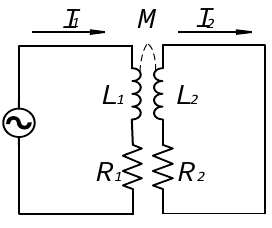
Figure 3. The equivalent circuit of the SECS.